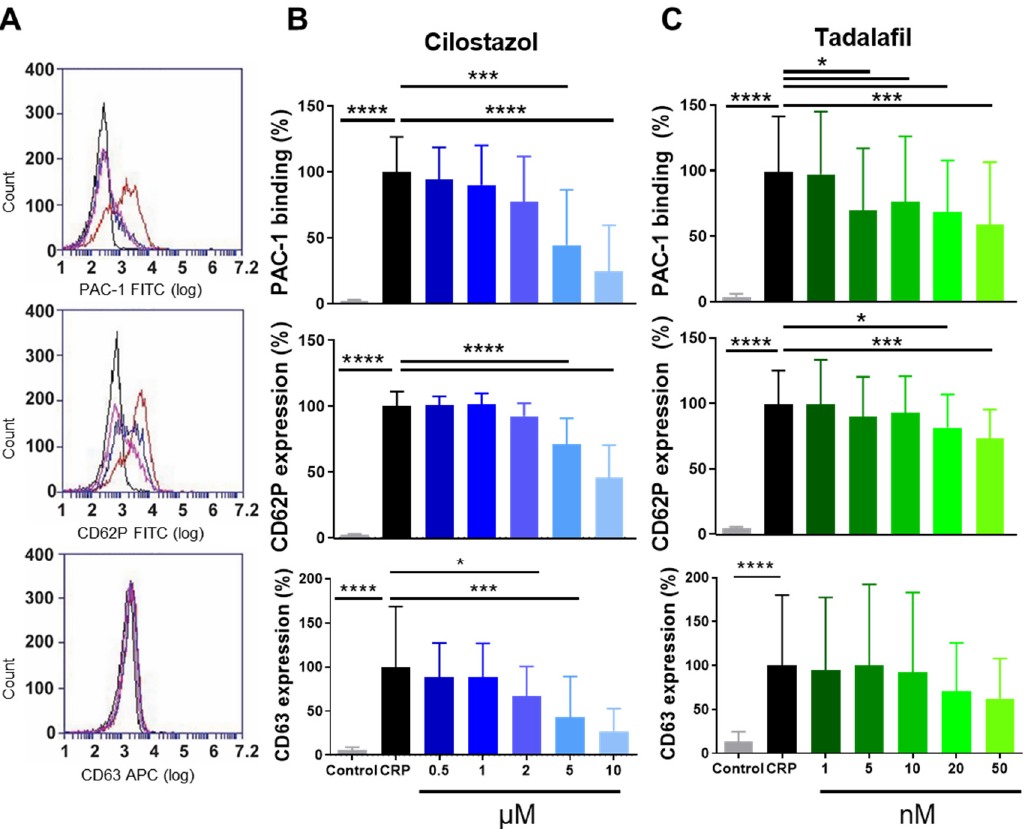
Figure 1. PDE3A and PDE5 inhibition dose-dependently decreases platelet integrin activation and granule secretion. Washed platelets were activated with collagen-related peptide (CRP, 0.3 µ g/mL) and platelet integrin α IIb β 3 activation (PAC-1: 65.68 ± 17.42%) and platelet α -granule secretion (CD62P: 72.74 ± 8.17%), dense-granule secretion (CD63: 20.36 ± 13.97%) were measured by flow cytometry ( A ). Dose-dependent decrease by PDE3A ( B ) and PDE5 ( C ) inhibition. Data in duplicate in the percentage normalised against the activated platelets without inhibitor are shown. Corresponding vehicle controls were included for every condition. Histograms: black represents control, red represents CRP, pink represents cilostazol (5 μ M), and blue represents tadalafil (10 nM). Mean + S.D., n = 5–7, * p < 0.05, *** p < 0.001, **** p < 0.0001. Statistics: ordinary one-way ANOVA followed by Holm-Sidak’s multiple comparisons test. CRP, collagen-related peptide.